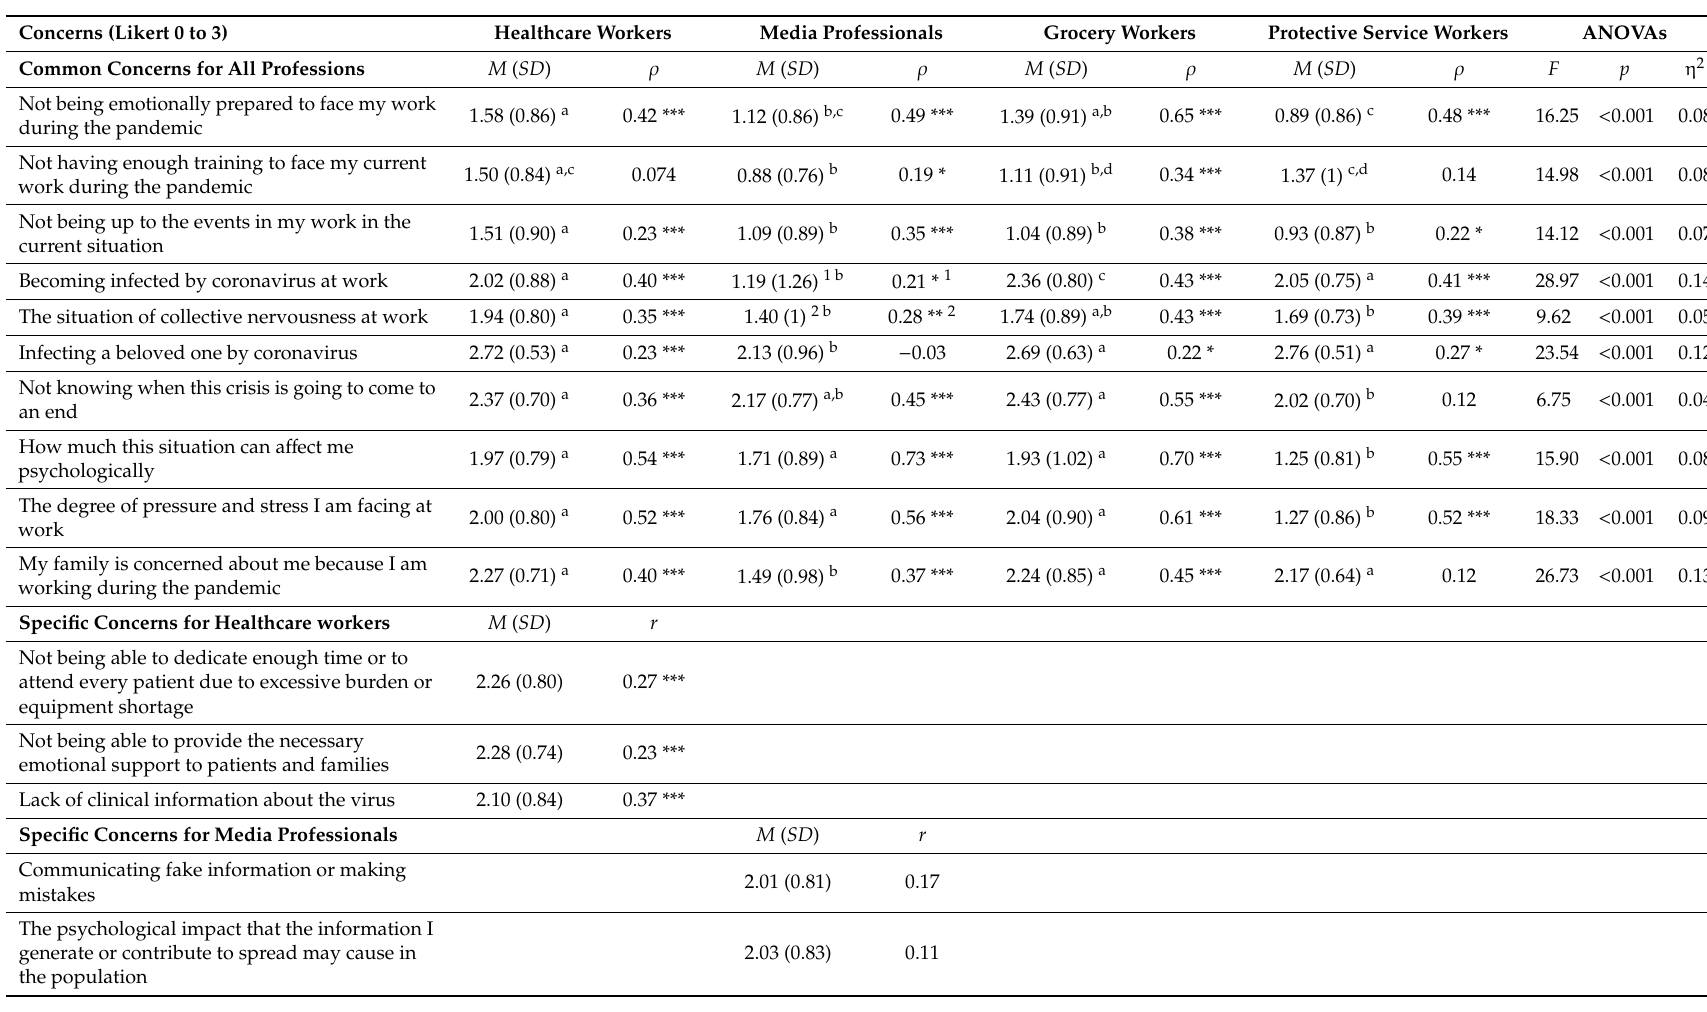
Table 3. Average level of concern in all the groups, the Spearman’s correlation ( ρ ) with psychological impact (IES-R standardized factorial score) and ANOVA results testing for di ff erences between groups of